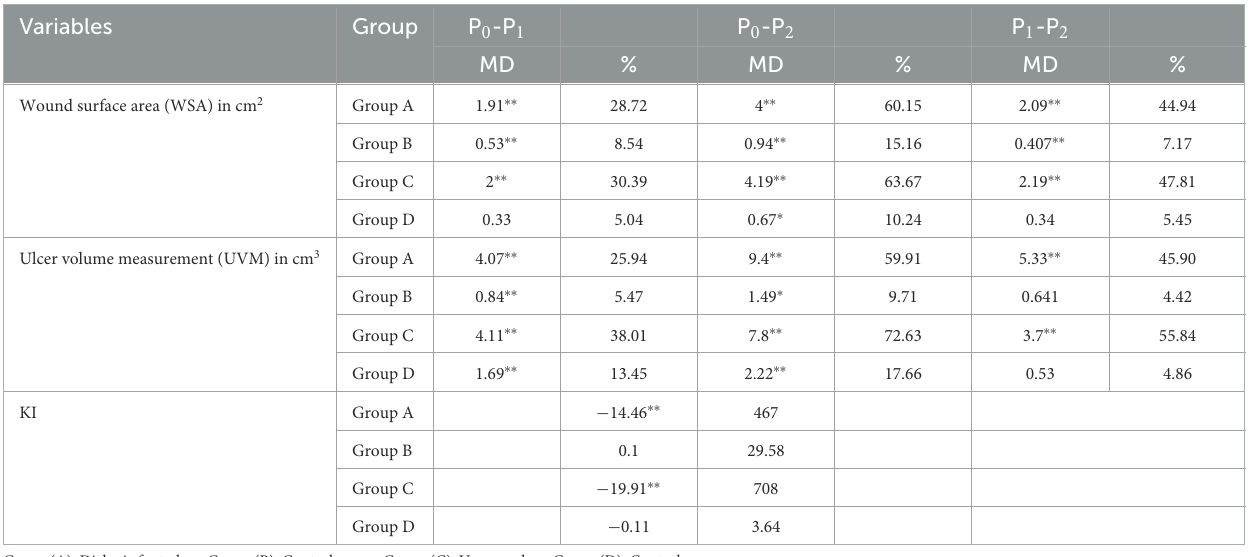
TABLE 3 Multiple pairwise comparisons among the three measuring periods for primary outcomes at each study group. Variables